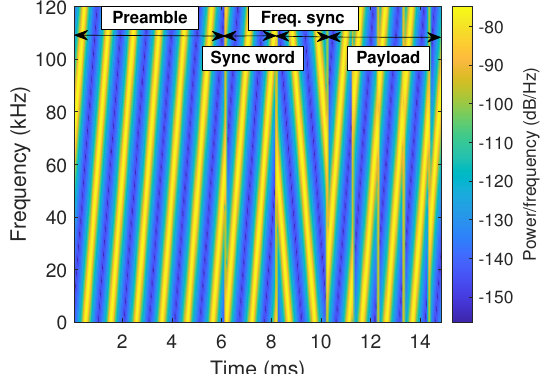
Figure 1. Spectrogram illustrating a baseband LoRa frame structure (SF = 7, T sym = 1ms, B = 125kHz). The three first elements (preamble, frame sync and frequency sync) are used for the synchronization process, and the last one (payload) contains the sensor data. Here, we only show four payload symbols to facilitate the visualization.